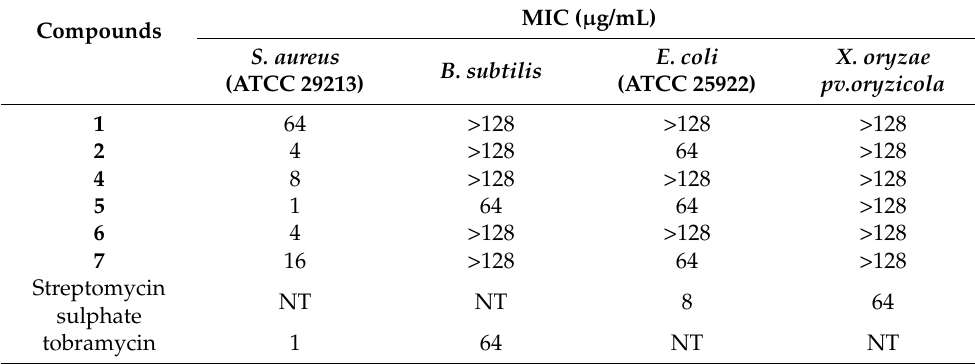
Table 3. The inhibitory effects of compounds 1 – 7 on bacteria.